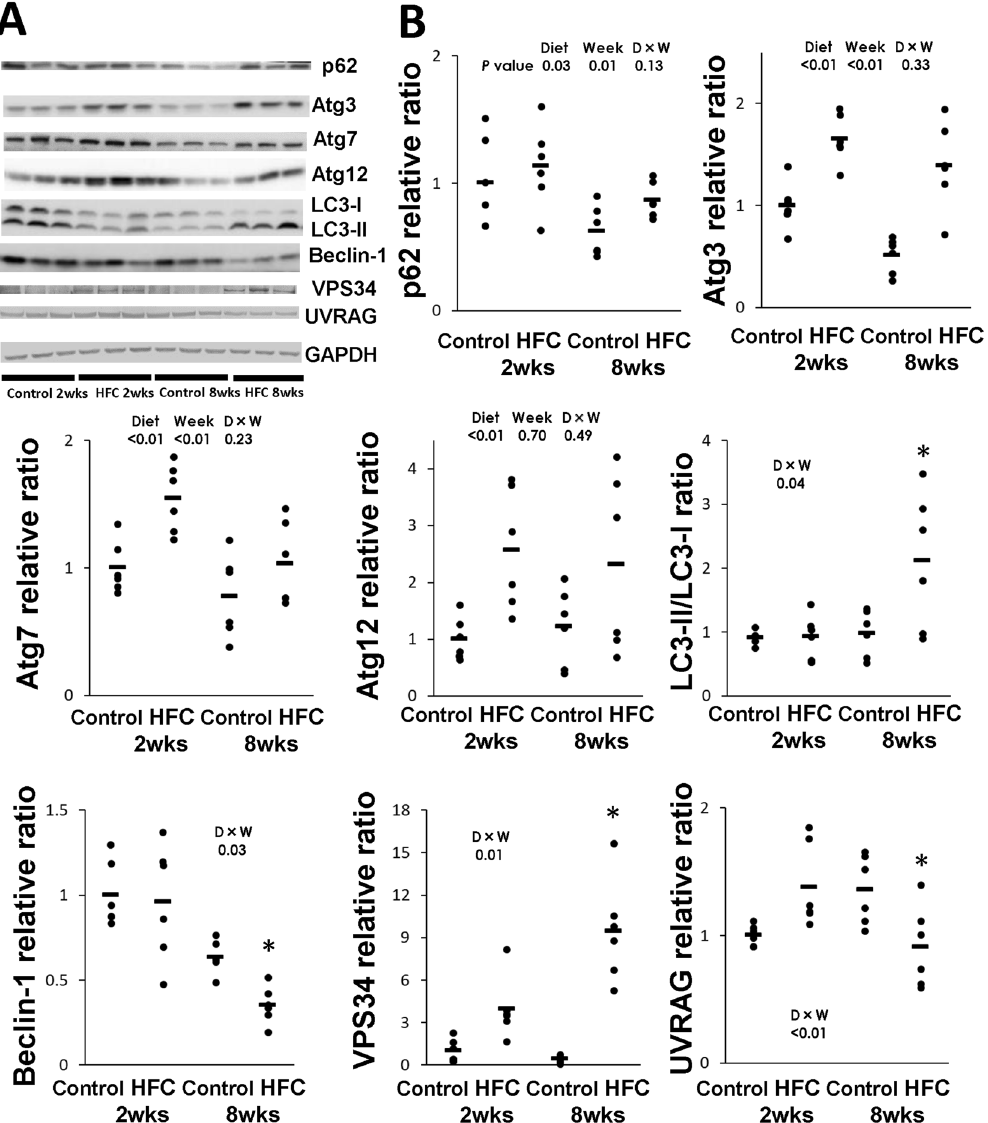
Figure 2. ( A ) Representative Western blot images of p62 and autophagy-related proteins (Atg) 3, 7 and 12, and microtubule-associated protein 1 light chain 3 (LC3), beclin-1, class III phosphatidylinositol 3-kinase (VPS34) and UV radiation resistance-associated gene protein (UVRAG). Samples were obtained from SHRSP5/ Dmcr rats fed control and HFC diets for 2 and 8 weeks. ( B ) Data are presented as means (bar) and dot plots for individual data. Glyceraldehyde-3-phosphate dehydrogenase (GAPDH) was used as a loading control. Wide- length blots/gel image are presented in Supplementary information. Data was analysed by two-way analysis of variance between diet and feeding duration (week). P values of diet, and week, D × W (diet × week interaction effect) were expressed within each graph. * Significant difference between HFC diet and control-diet groups, P <